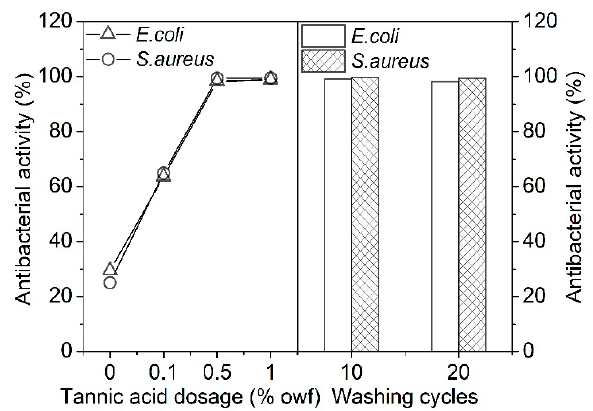
Figure 9. Antibacterial activity of the silk fabrics treated with different concentrations of tannic acid, and the washing durability of the silk fabric treated with 0.5% tannic acid.